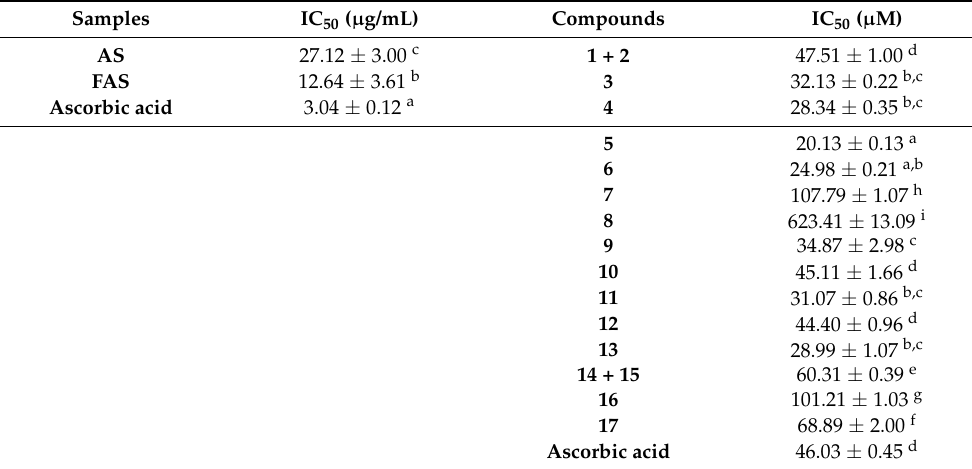
Table 2. IC 50 values of compounds 1– 17 for DPPH radical scavenging